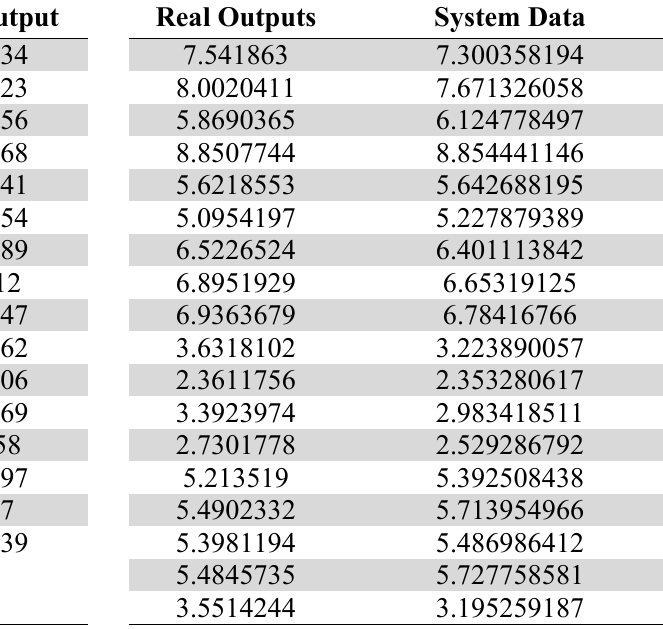
Comparing the Outputs of Credit Risk Evalu- ation Model with Real Outputs